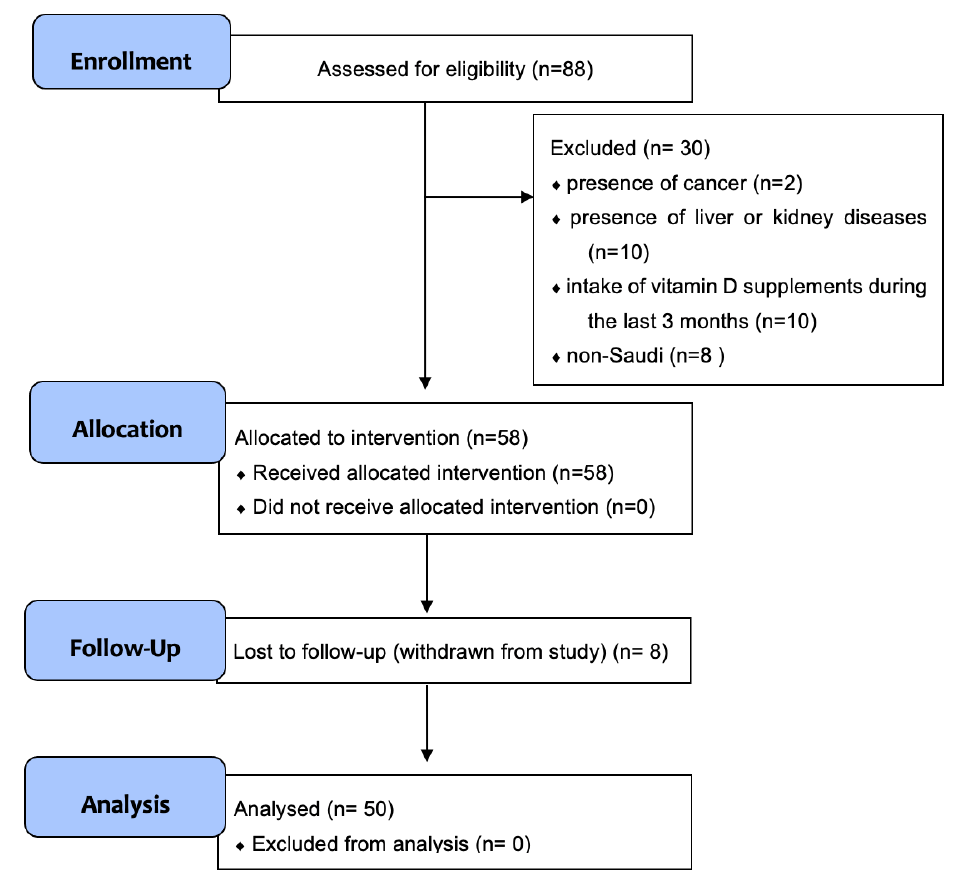
Figure 1. Flow chart showing the flow of the participants throughout the study. n = number of in- dividuals.